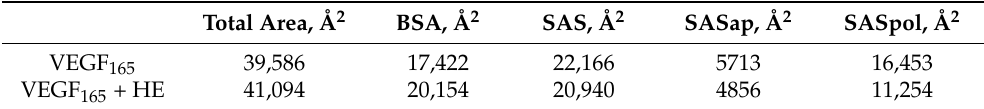
Table 2. Solvent-accessible area parameters calculated from the full structure models of VEGF 165 and VEGF 165 + HE using PyMOL v.